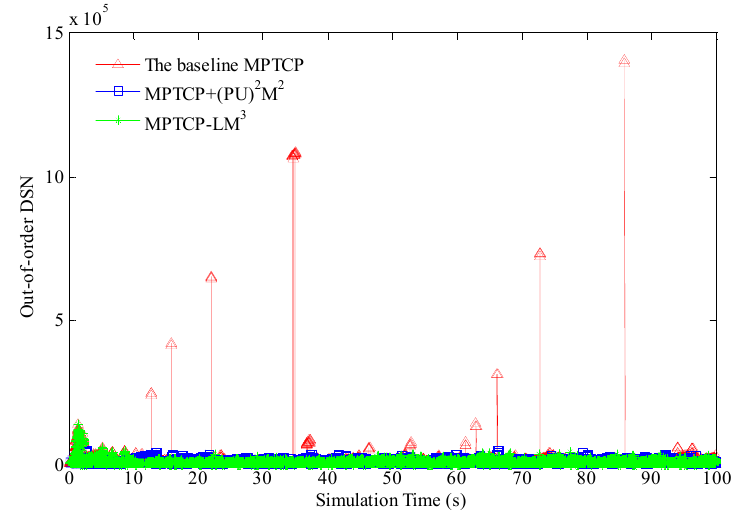
Figure 9. The comparison of out-of-order Data Sequence Number